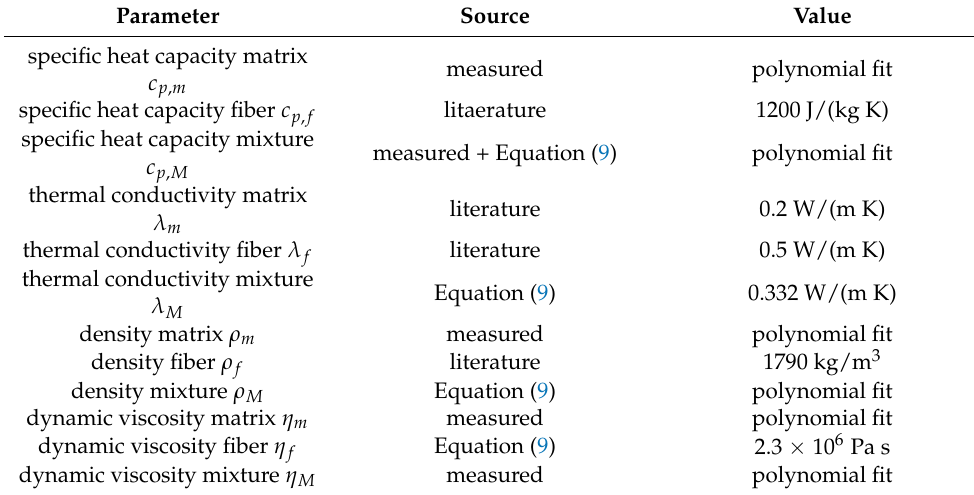
Table 1. Sources of the material